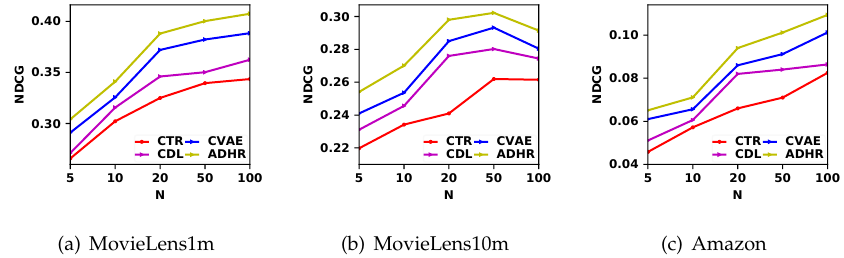
Figure 3. Cold-start recommendation performance w.r.t. different values of